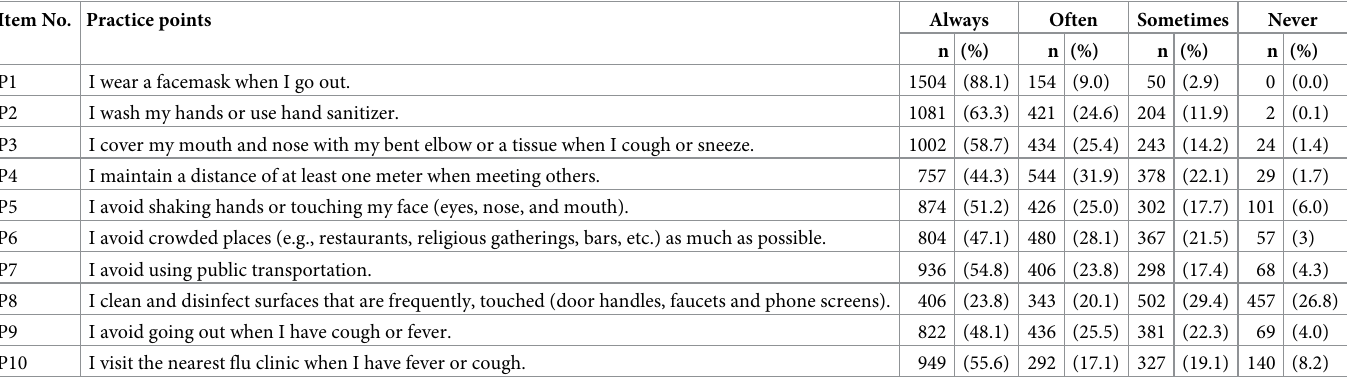
Table 5. COVID-19 preventive practices among participants surveyed for the knowledge, attitude and practices survey in Bhutan, January–February, 2022 (n = 1708). Item No. Practice